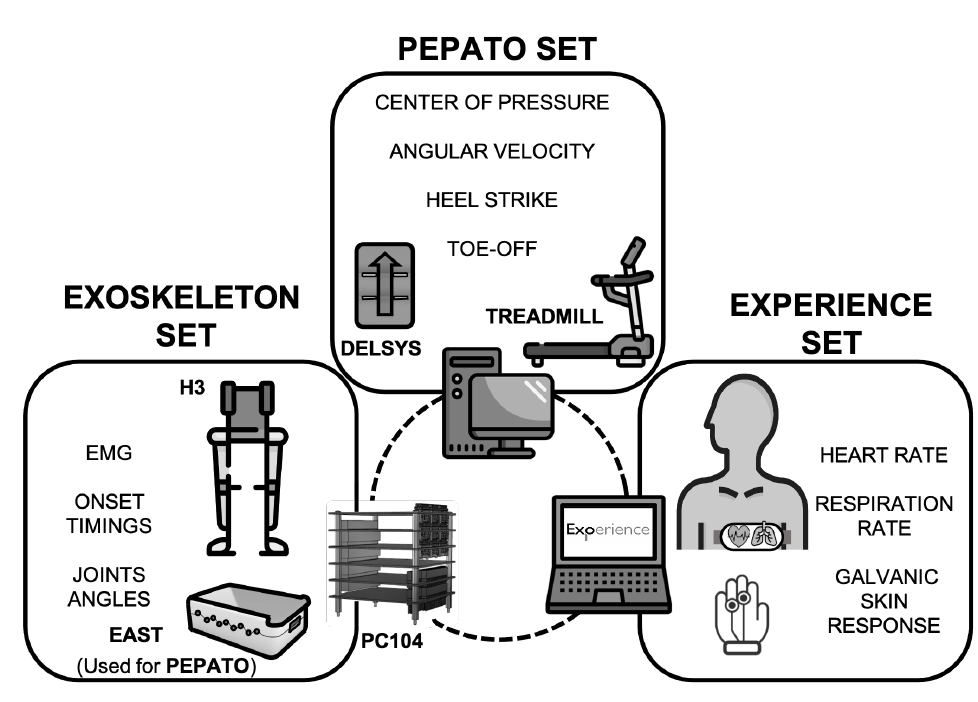
Figure 4. Experimental setup. Figure 5 shows the front view (on the right) and the rear view (on the left), from two different subjects while they walked with Exo-H3.